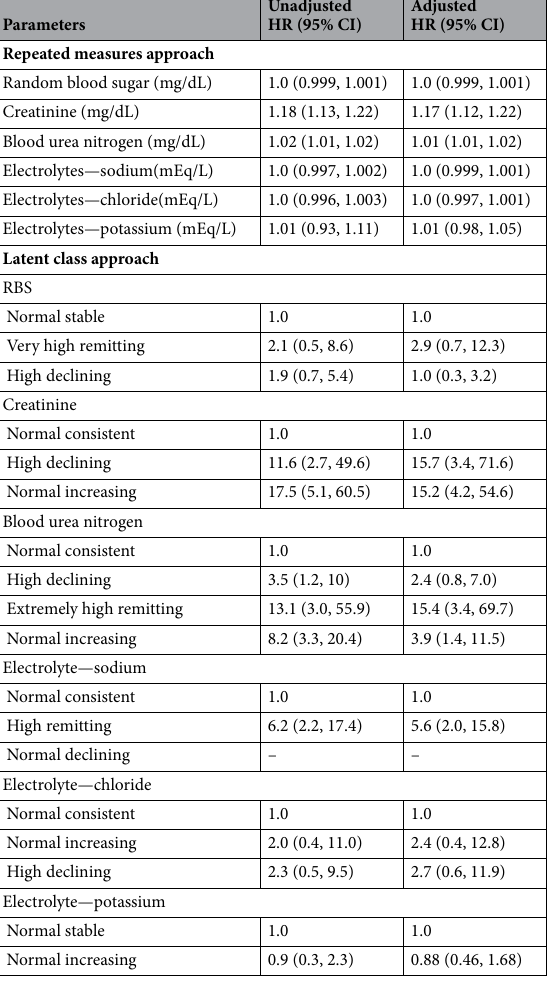
Table 3. Two approaches in relationship of ICU-mortality with biochemical parameters using Cox model. HR hazard ratio. Adjusted covariates: (for repeated measure: age, for latent class: age and elapse